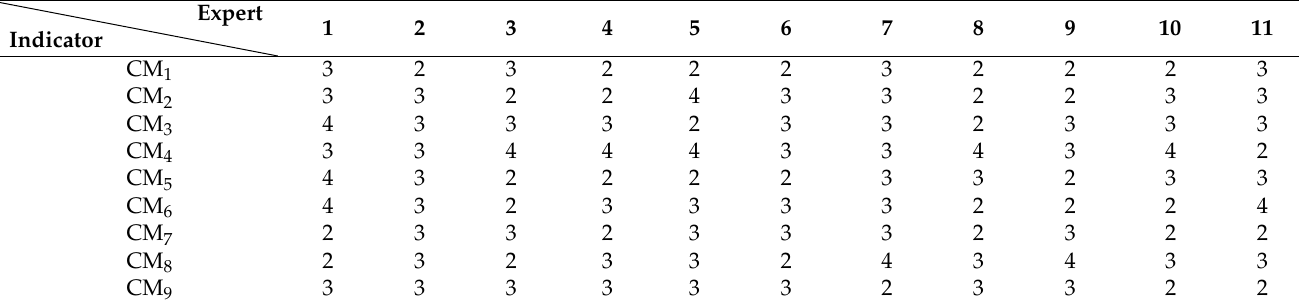
Table A13. Table A13. Raw data of construction management risk (CM).